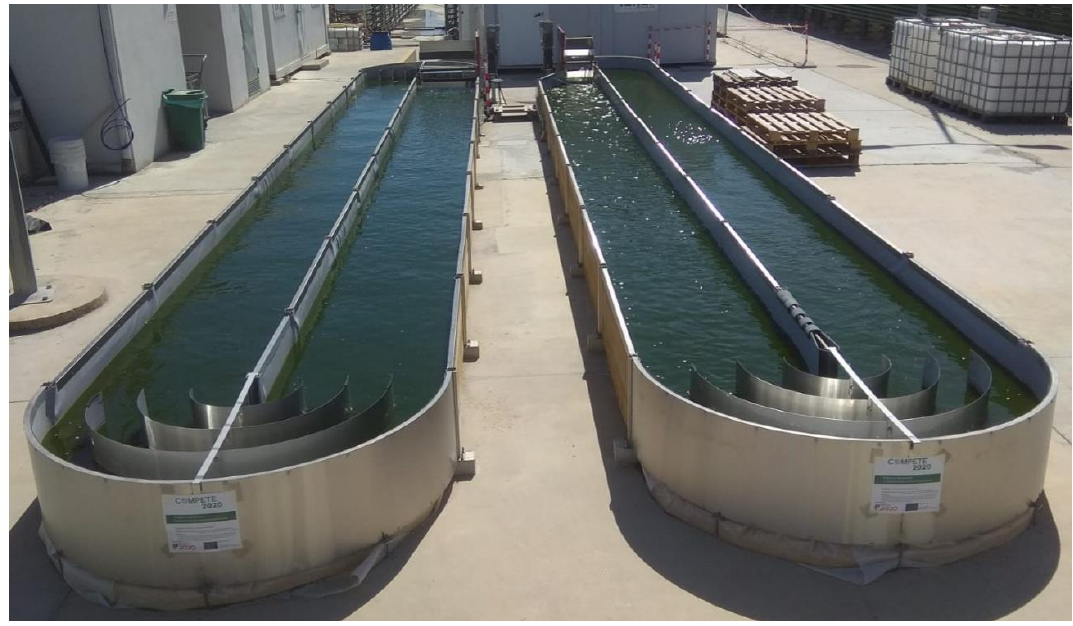
Figure 2. Pilot-scale raceway ponds used. Modified raceway at right and standard raceway at left.